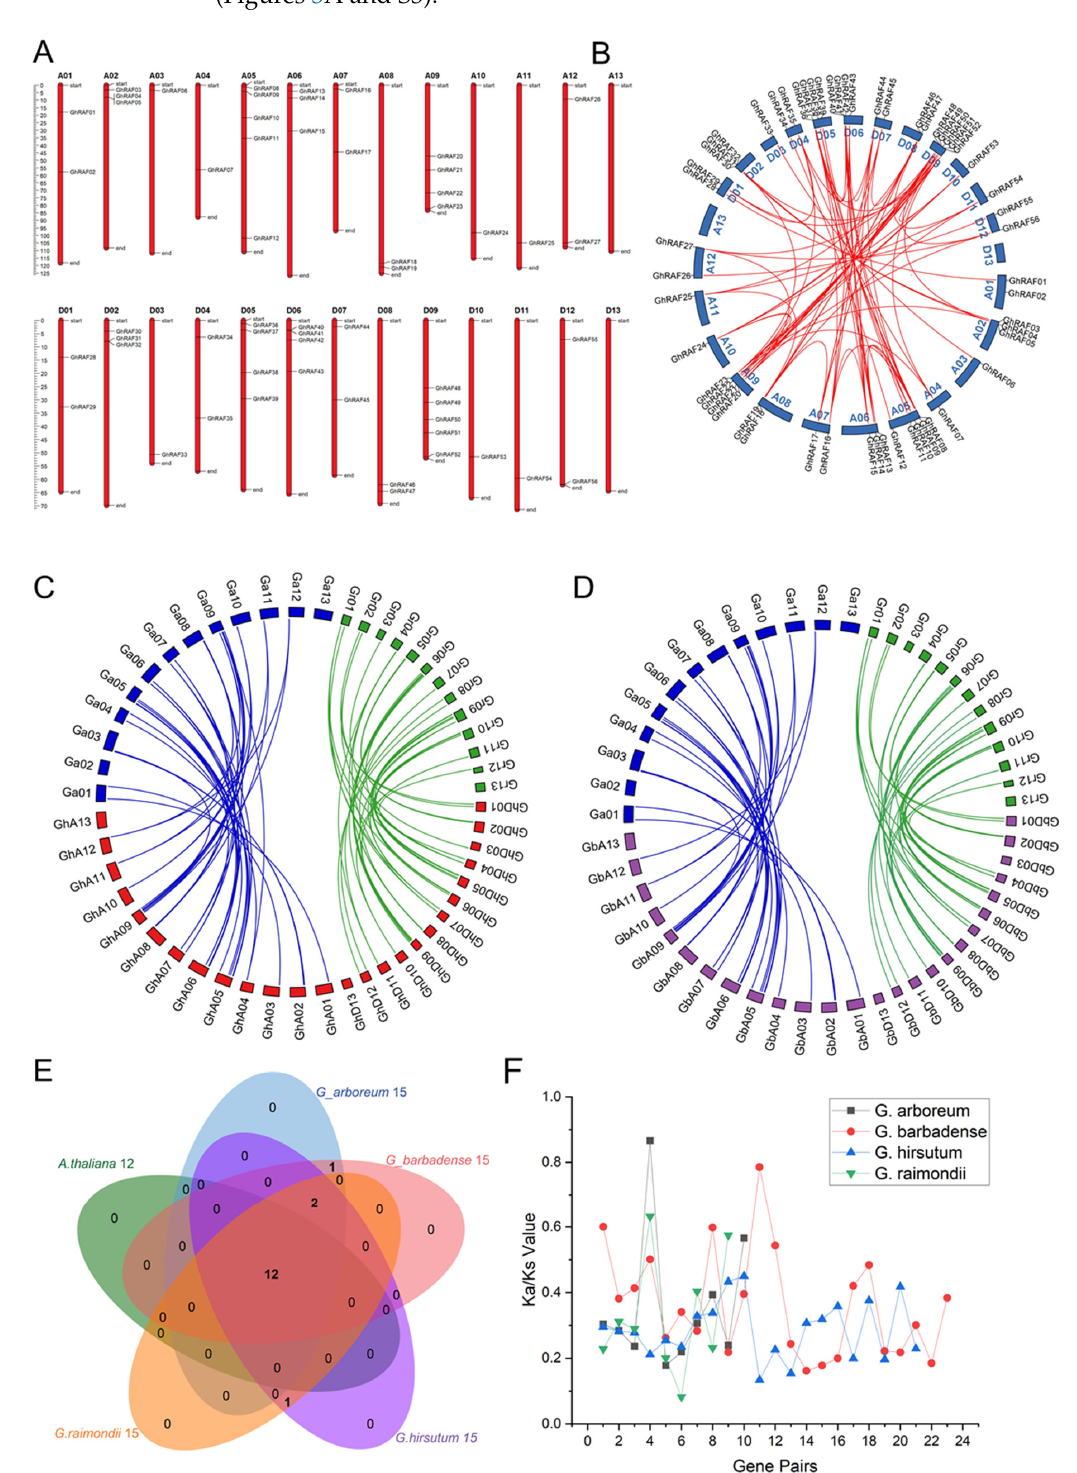
Figure 3. RAF gene distribution on chromosomes, collinearity, synteny and duplication events analysis of RAF genes in cotton ( A ) Chromosomal map ( B ) Circos diagram of G. hirsutum ( C ) Synteny diagram involving G. arboreum , G. raimondii and G. hirsutum ( D ) Synteny diagram involving G. arboreum , G. raimondii and G. barbadense ( E ) Venn Diagram among different species clusters ( F ) Synonymous and nonsynonymous ratio.